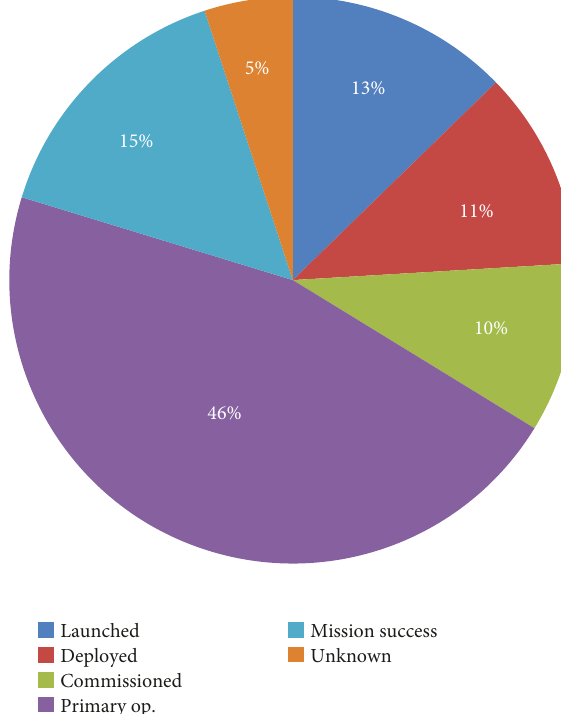
Figure 7: Distribution of CubeSats according to their mission status as of May 31,